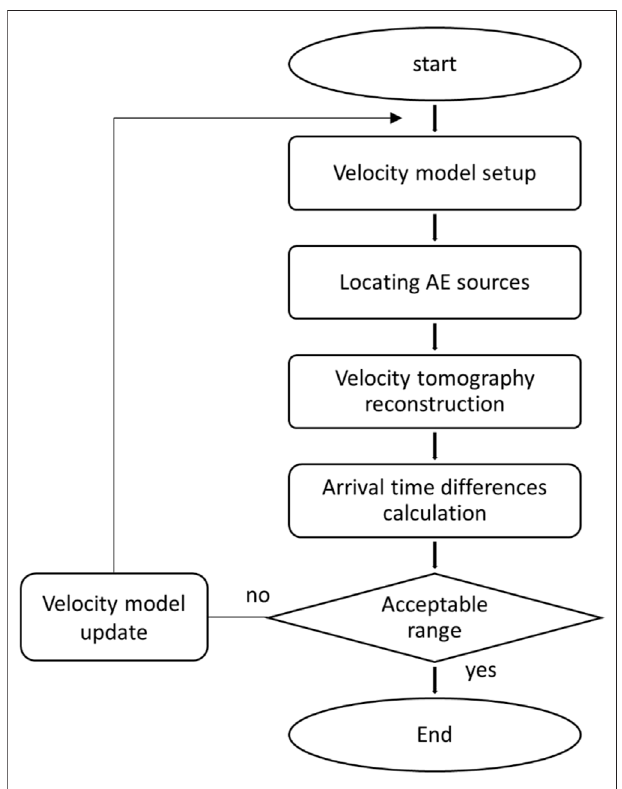
FIGURE 1 | Illustration of AE tomography